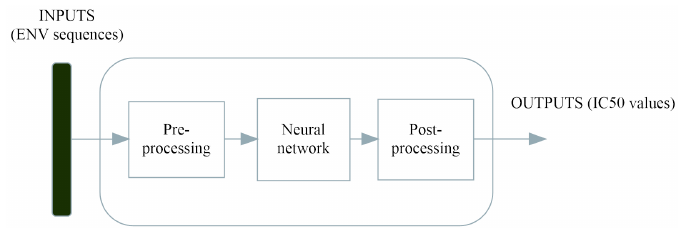
Figure 9. Modeling (learning) neutralization data using a feedforward neural network.